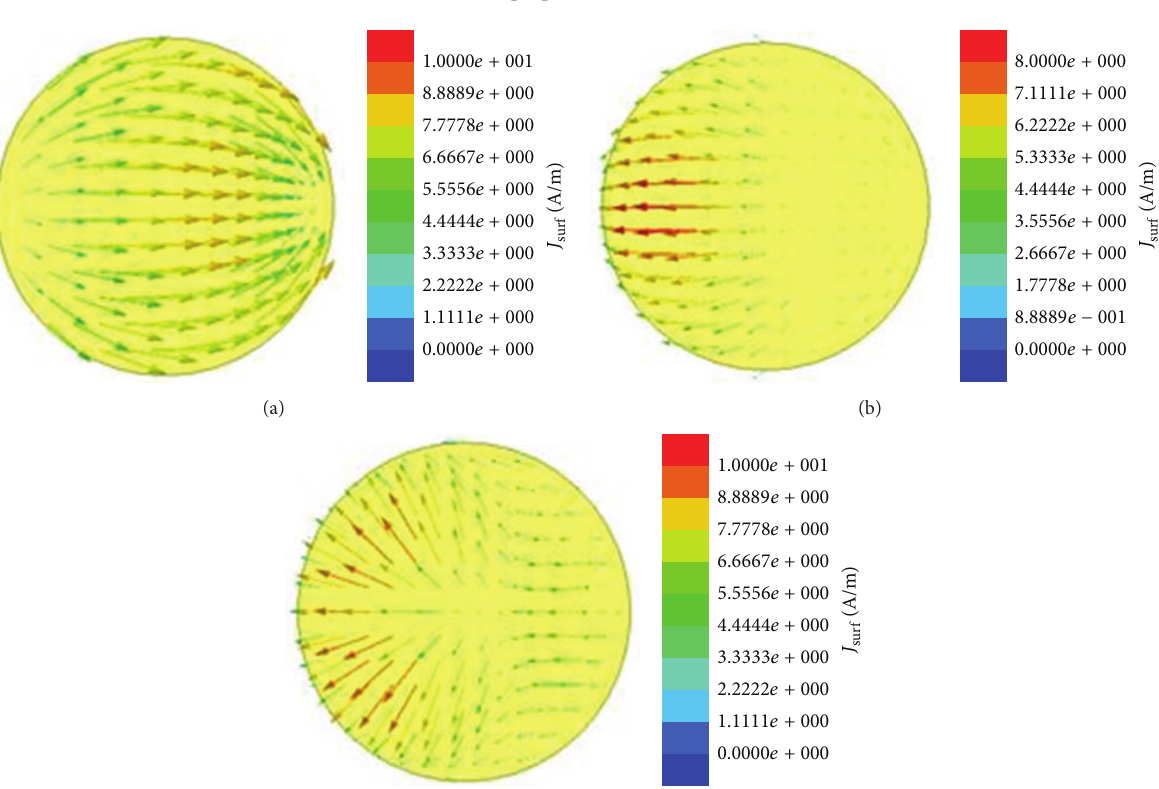
Figure 3: Electrical field distribution of the proposed DRA. (a) 3.0 GHz, (b) 5.0 GHz, and (c) 6.5 GHz.